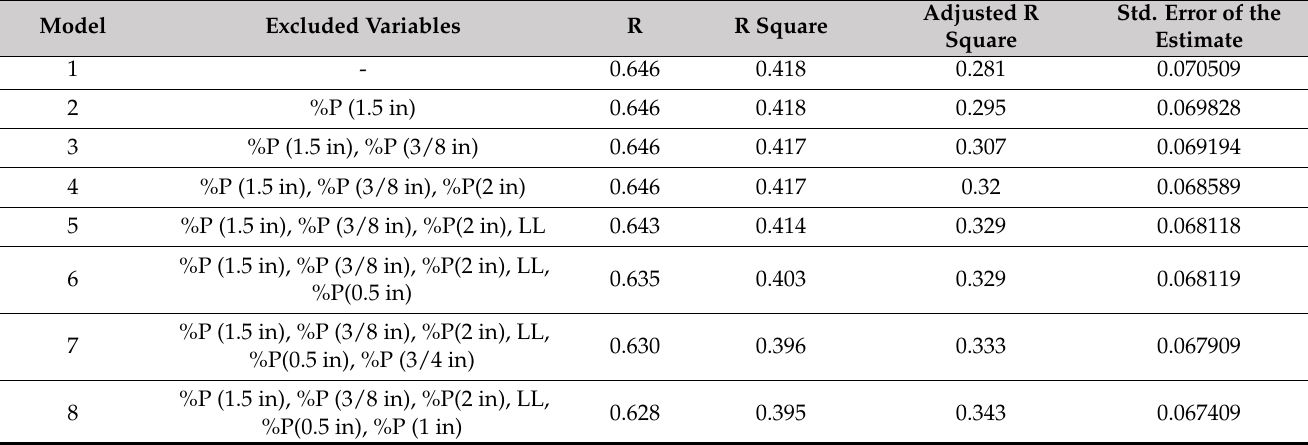
Table 7. Details of the MLR models developed for the MDD during the backward elimination process. Model